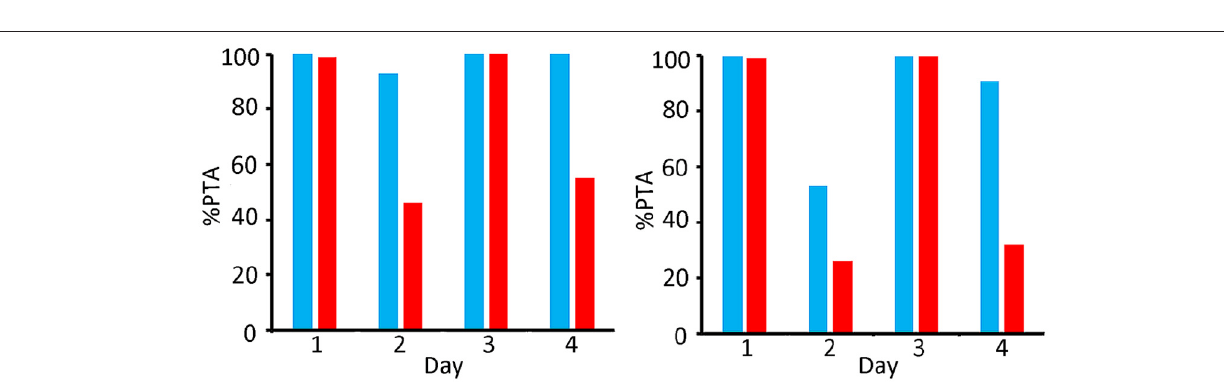
Results for the 100 kg steers were compared to the results of the 400 kg steers (see Figures 7 , 8